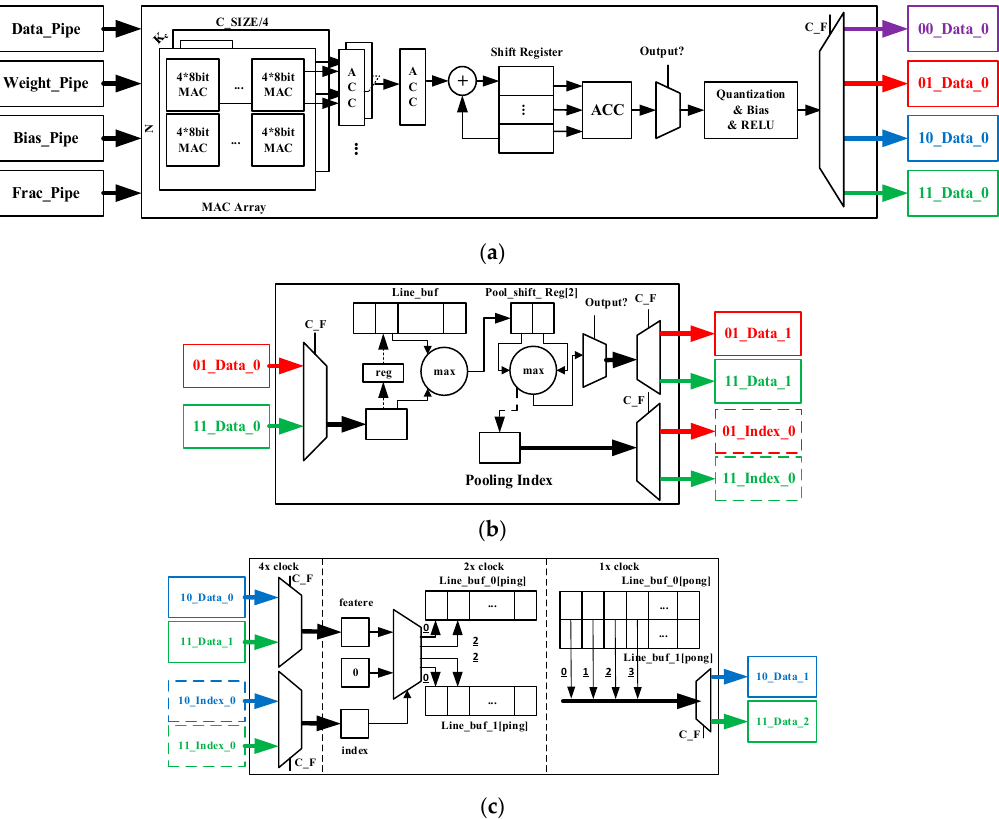
Figure 4. Architecture of kernels in EDSSA. ( a ) Convolution kernel; ( b ) pooling kernel; ( c ) unpooling kernel.